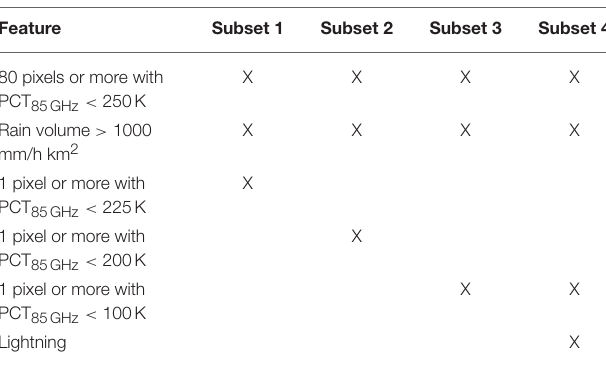
TABLE 2 | Criteria for selection of potentially severe cases in the region containing the Amazon Basin (20 ◦ S–10 ◦ N and 80 ◦ W–40 ◦ W). Feature